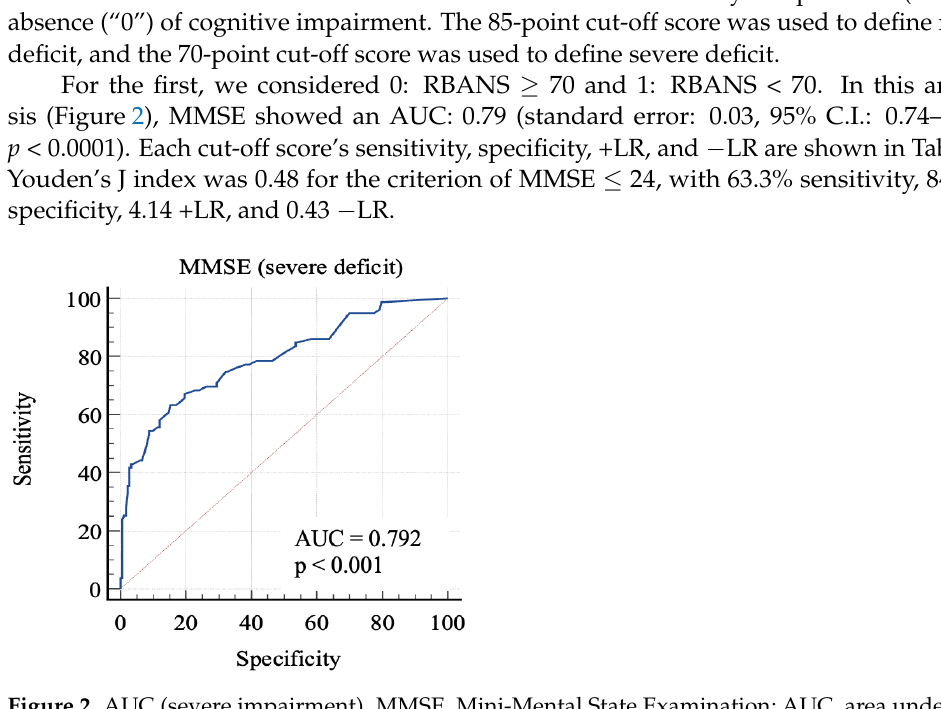
Figure 2. AUC (severe impairment). MMSE, Mini-Mental State Examination; AUC, area under the ROC curve. Table 3. Criterion values and coordinates of the ROC curve (severe impairment).